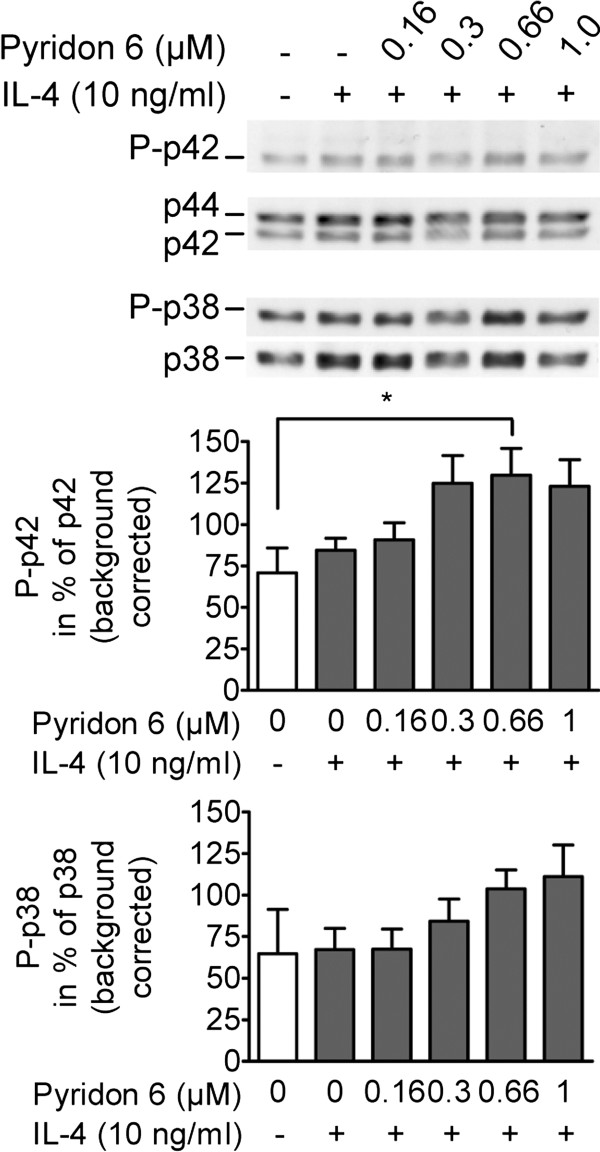
IL-4 and pyridon 6 do not interfere with MAP kinase pathways. Lymphocytes were preincubated for 30 min with/without pyridon 6 and stimulated for 2 h with IL-4. Cell lysates were subjected to Western Blotting followed by densitometry. Representative immunoblots show p42 and p38 phosphorylation; loading was controlled by staining for non-phosphorylated p44/42 (42/44 kDa) and non-phosphorylated p38 (38 kDa), respectively. Densitometry results are given as mean % expression of loading control ± SEM in the bar graphs; statistical analysis was performed using the Friedman and Dunn’s test; *P < 0.05. The number of independently performed experiments was n = 4 for p42 and n = 3 for p38 phosphorylation.